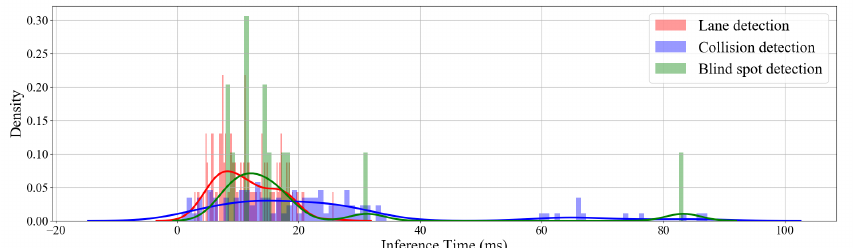
Figure 23. Density distribution plot, showing the processing times for collision, lane, and blind spot detection.